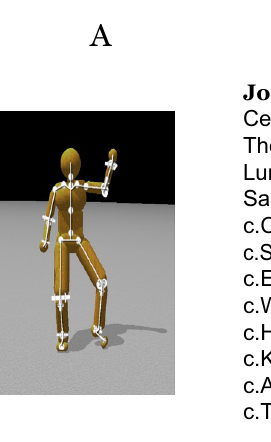
Figure 9. The 48 internal DOF Model 28 . ( A ) Four ball-and-socket joints connect five body-segments along the spine from the head to the waist. Ball-and-socket joints are also used at the collar-bone, shoulder, and hip. ( B ) A summary of the joints used in the model. c. = chiral: there are two of each of these joints (left and right). Universal joints are used at the elbows, wrists, knees, and ankles. Hinge joints connect the toes to the heels. All joints limit the range of motion to angles plausible for human movement. Our model assumes that joint DOFs summarize the effects of component